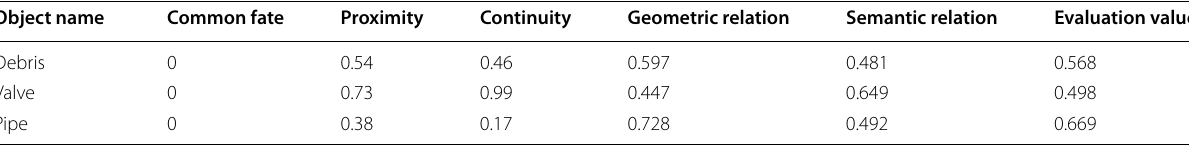
Table 7 Each evaluation value at Frame =